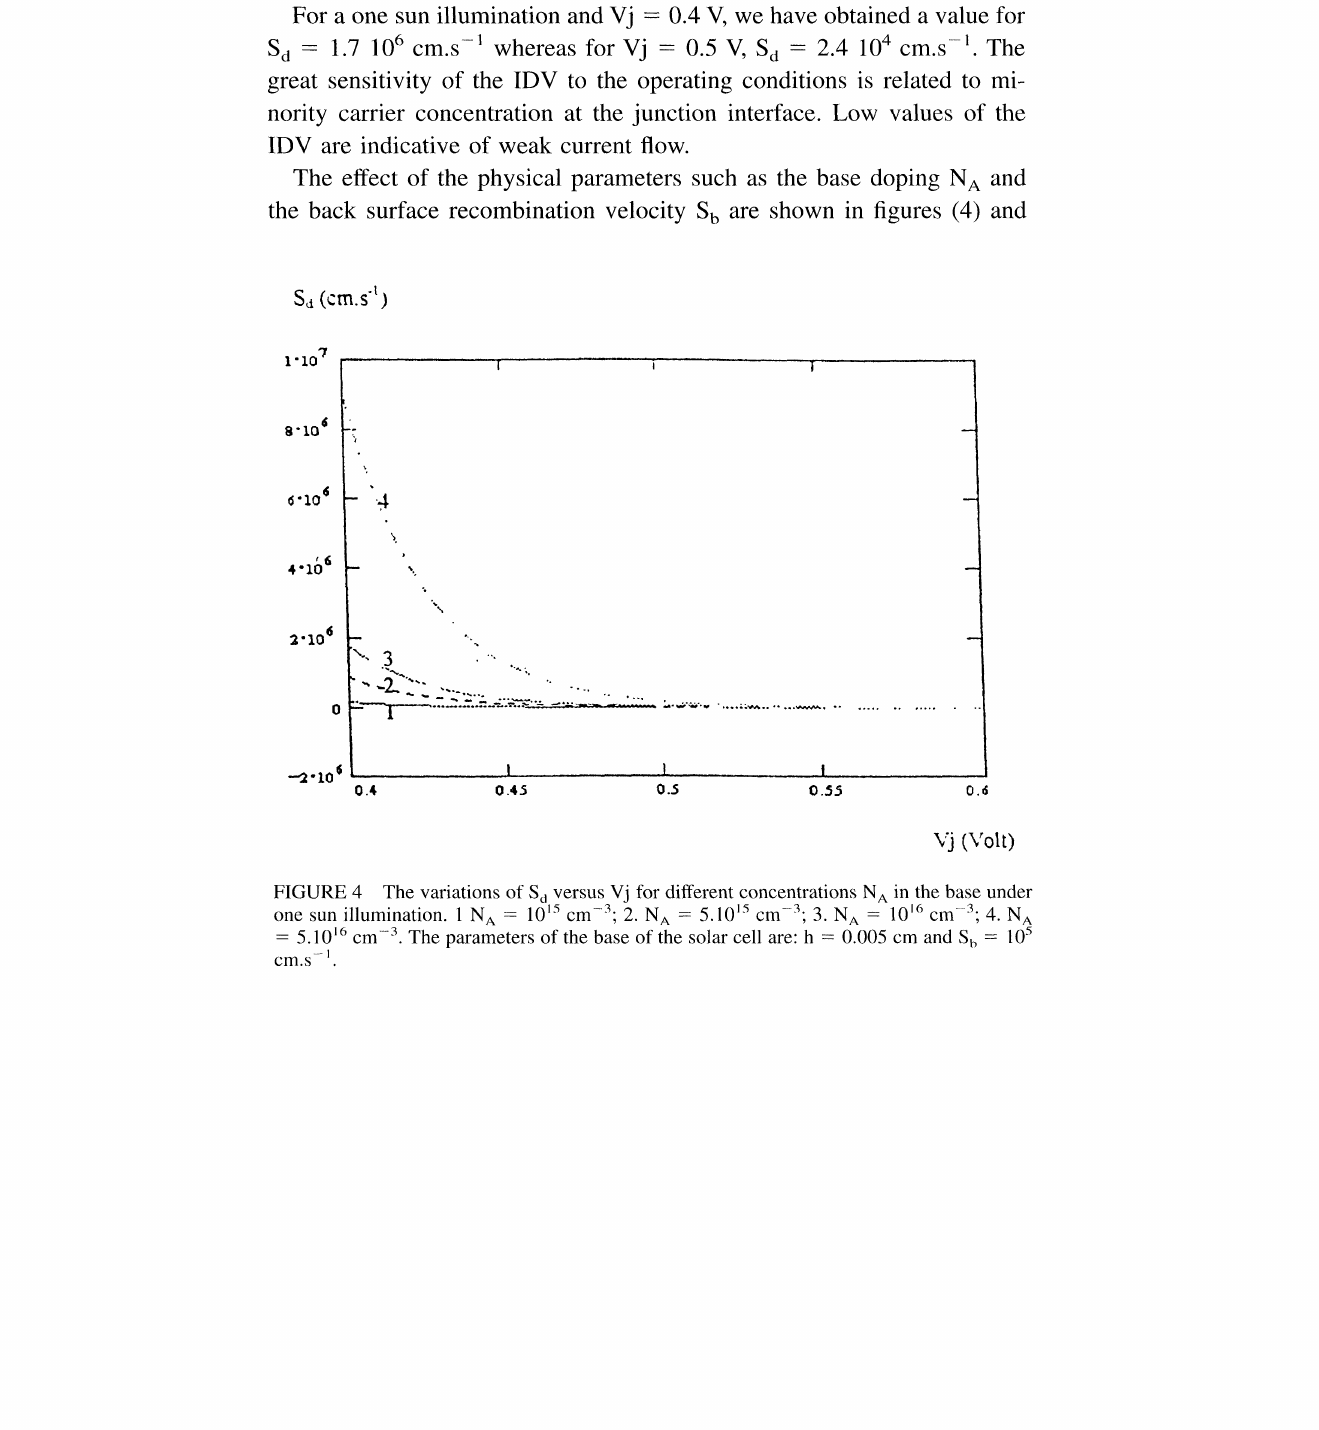
A in the base under